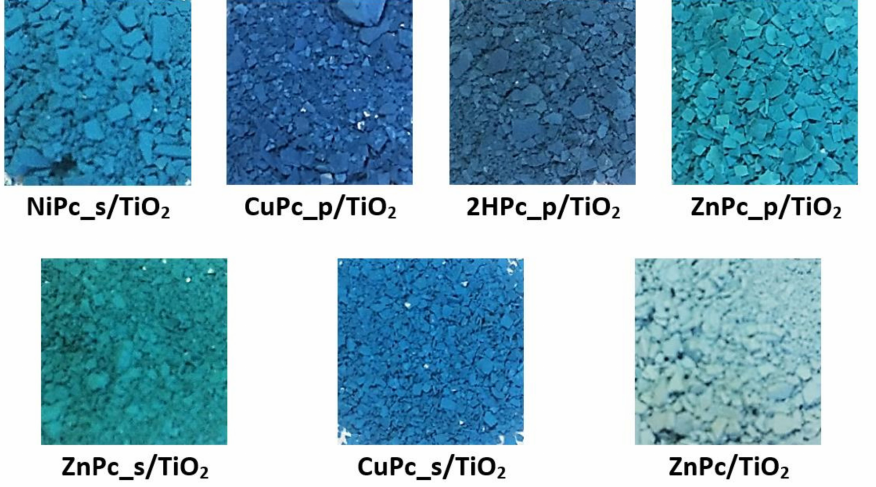
Figure 6. Photographs of the obtained photocatalytic